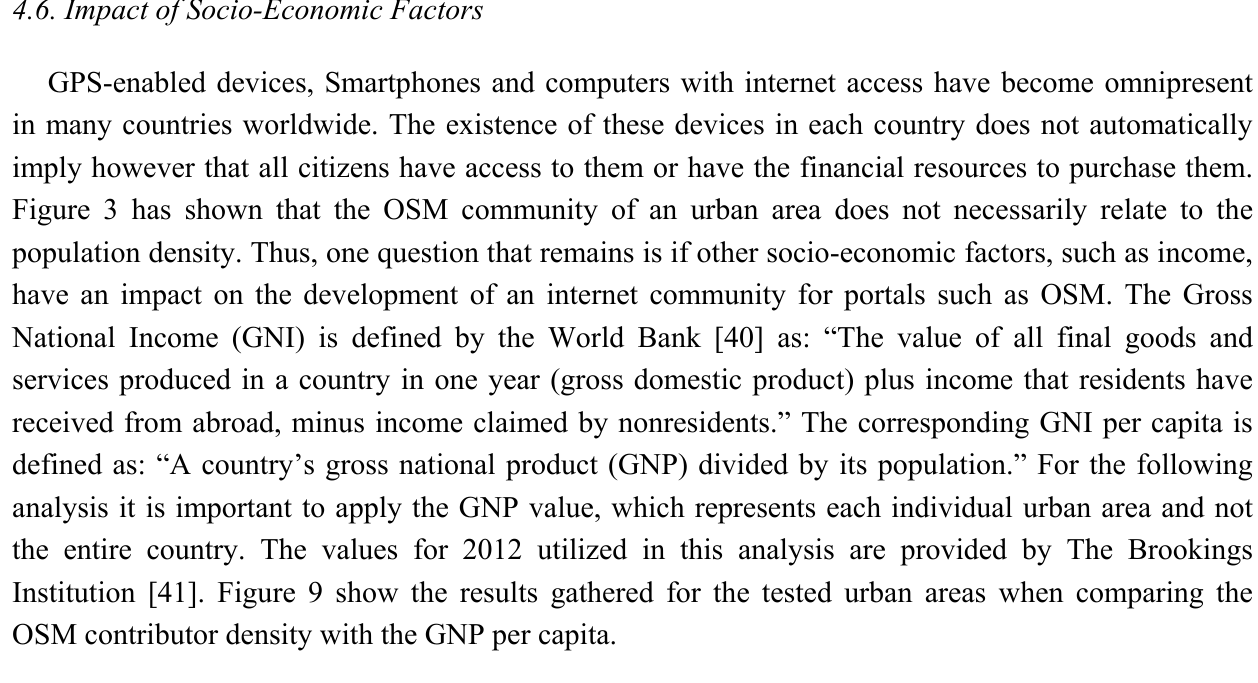
Figure 9. Contributor density (Oct. 2012) and GNP per capita